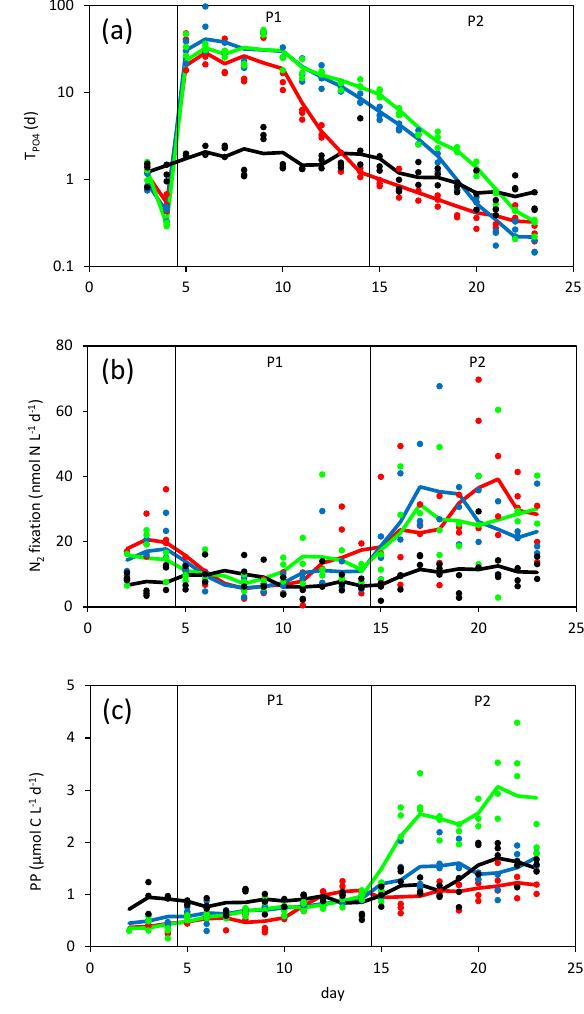
Figure 1. Temporal evolution of (a) phosphate turnover time ( T PO days), (b) dinitrogen fixation (N 2 fixation) rates (nmolNL − 1 d − 1 ) and (c) primary production (PP) rates (µmolCL − 1 d − 1 ) in the mesocosms M1 (red), M2 (blue) and M3 (green) and in surround- ing waters (black). The three dots of each color represent the measured values at the three sampled depths. The solid lines are the 3-day running mean value. P1 and P2 denote the two phases of the experiment when the diazotrophic community was domi- nated by diatom–diazotroph associations and unicellular N 2 -fixing cyanobacteria (group C),